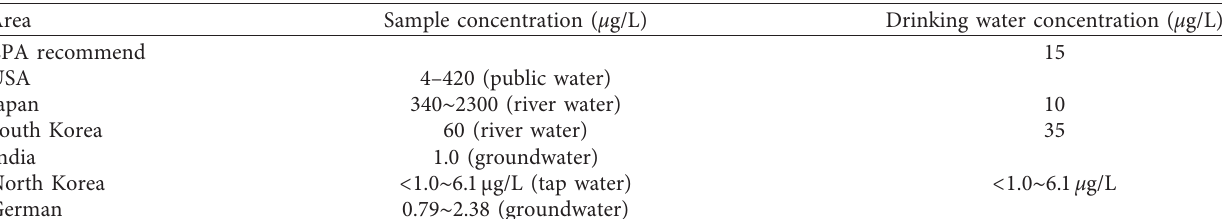
Table 2: The global pollution situation of